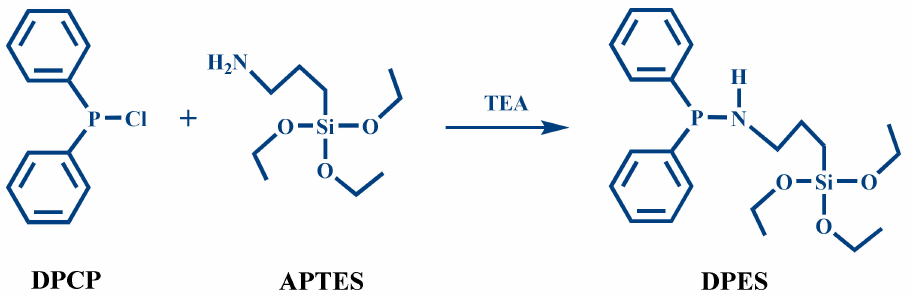
Figure 1. The synthesis route of